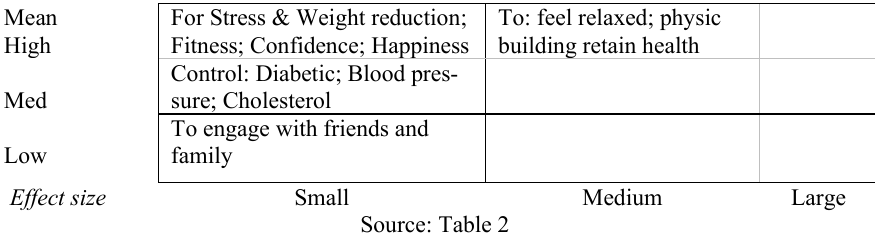
Fig. 2. Priority for visiting fitness center; mean and effect size for male vs